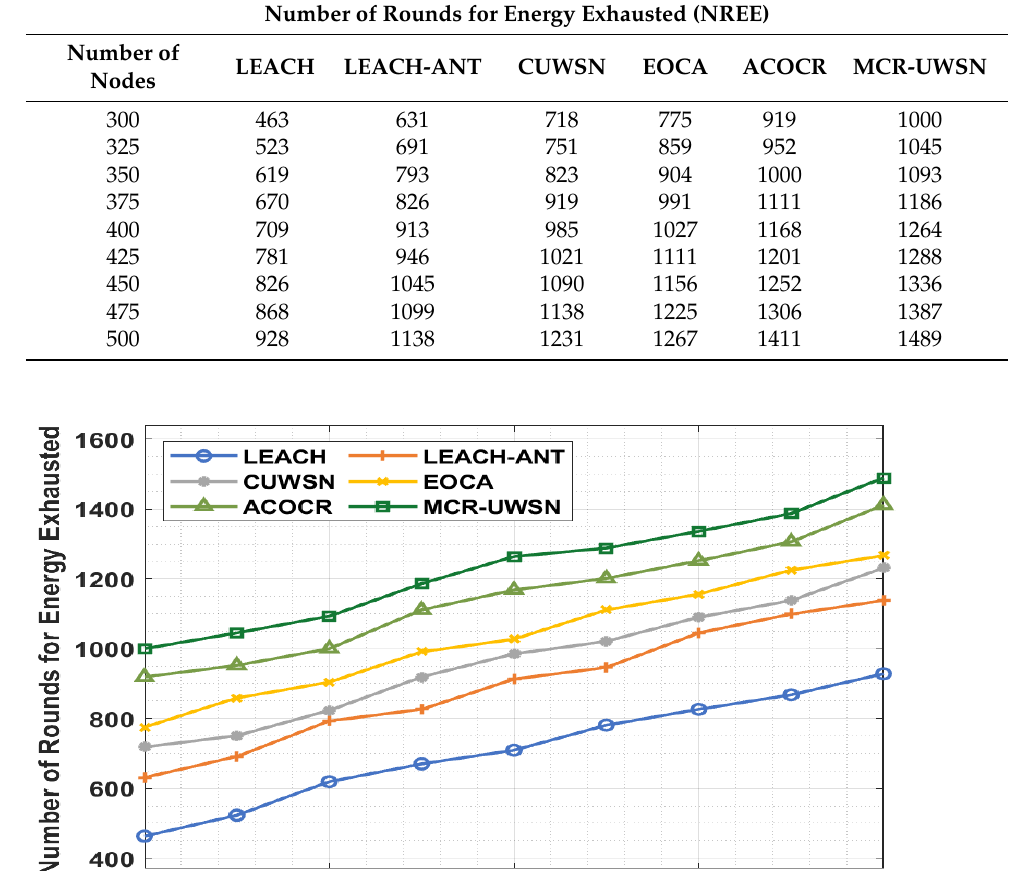
Table 2. Result analysis of MCR-UWSN model in terms of the number of rounds for energy ex- hausted (NREE).